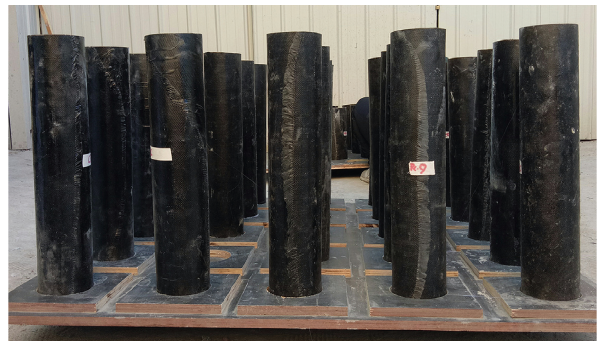
Figure 1: BFRP tubes for concrete